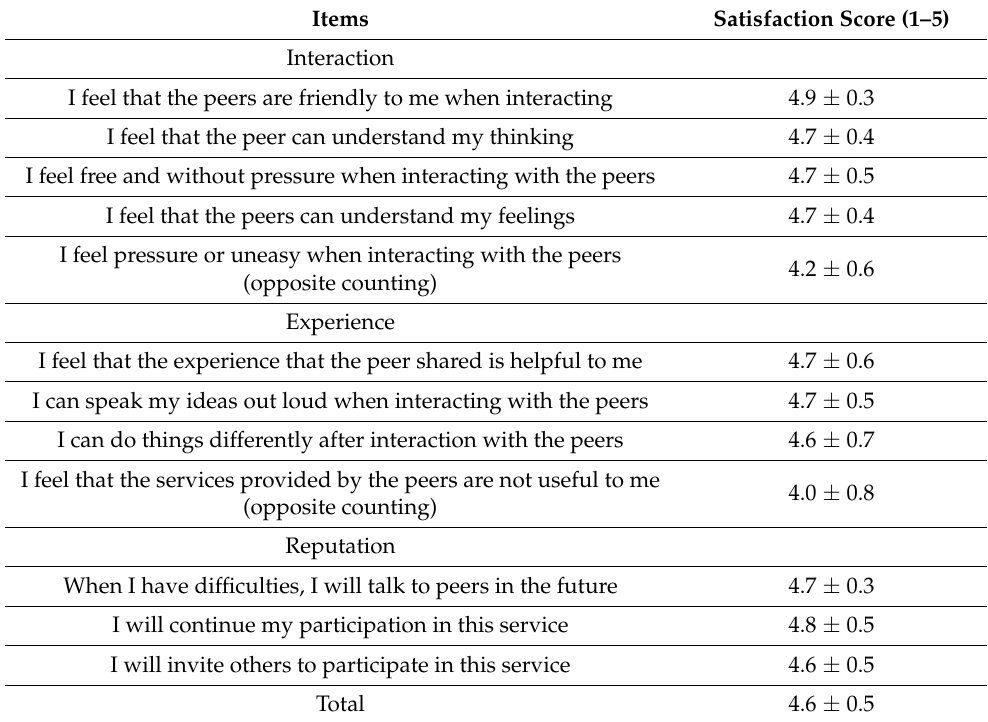
Table 4. The satisfaction of services based on internship for service users ( n = 29, 236